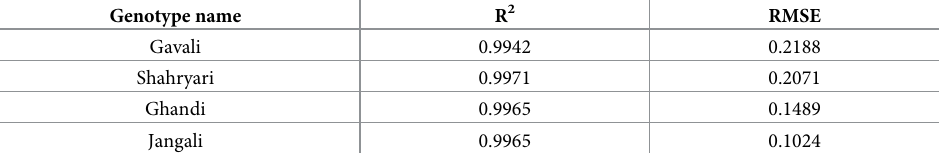
Table 10. Evaluation results of the 2019 data-based trained ANFIS model on the data collected in 2021 from three greengage plum genotypes and one myrobalan plum.